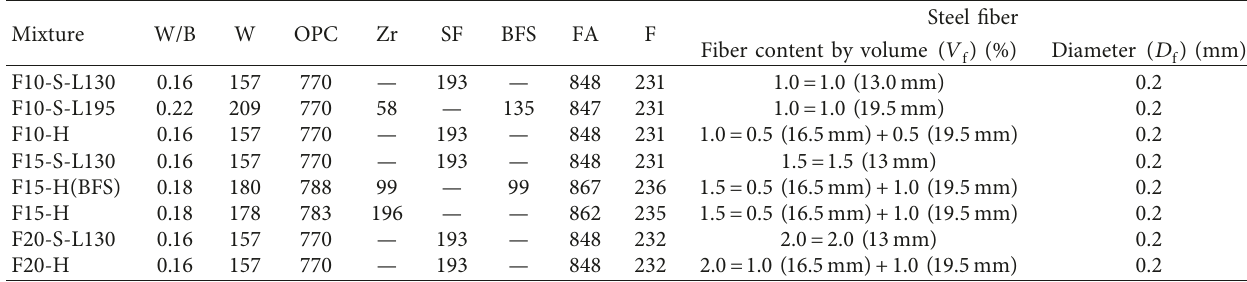
Table 1: Mix proportions of the